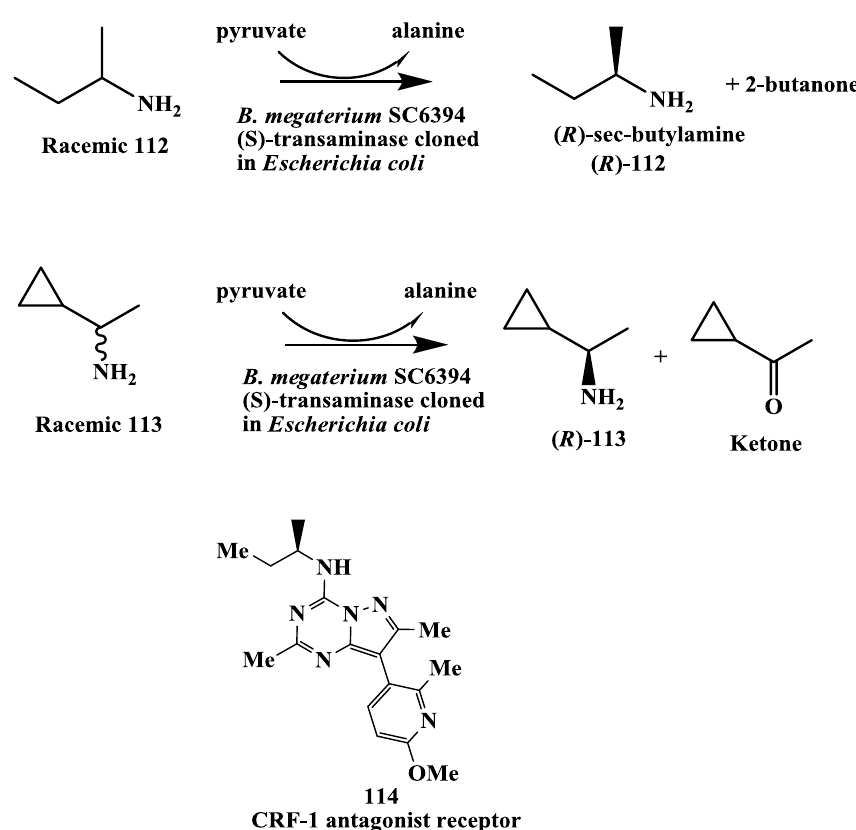
Figure 31. Corticotropin releasing factor (CRF)-1 receptor antagonist: Enzymatic synthesis of ( R )-1-cyclopropylethylamine and ( R )- sec